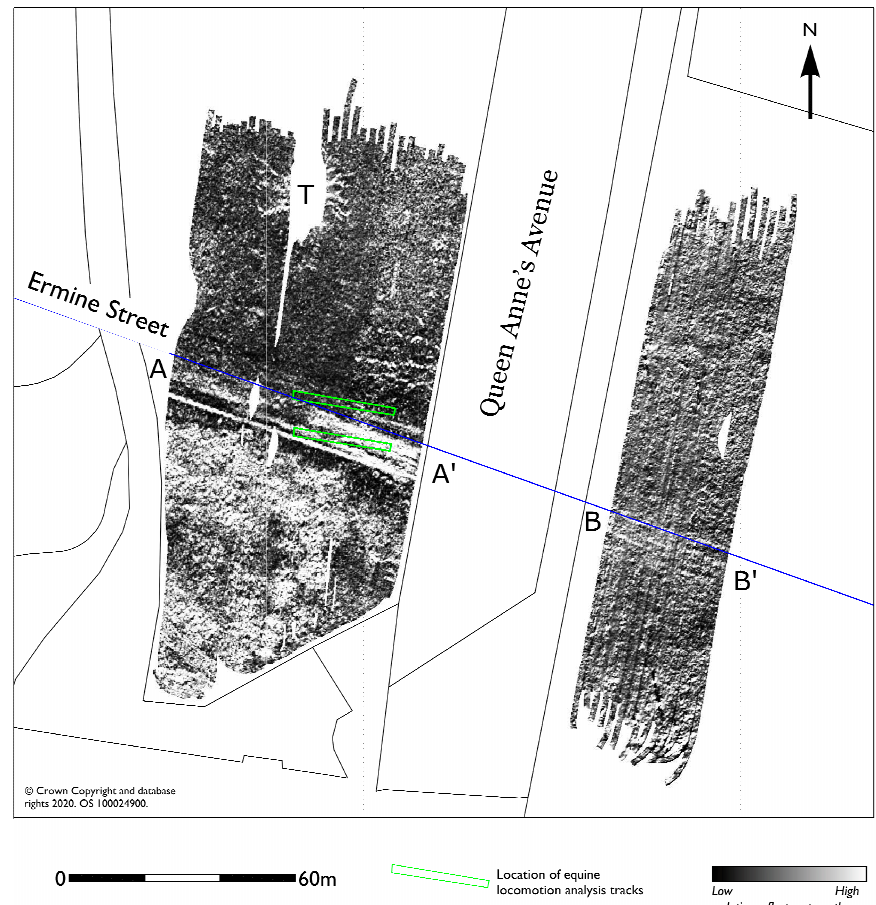
Figure 5. GPR amplitude timeslice from between 5.0 and 7.5 ns (0.27 to 0.4 m) showing the course of the Ermine Street Roman road (blue line) that survives better in the park land (AA’) to the west of Queen Anne’s Avenue, than in the field to the east (BB’) which has been subject to a more intense arable regime in recent years before being put down to grass. The two experimental tracks for the equine locomotion analysis are shown by the green boxes. Some gaps in the GPR coverage were necessary due to the presence of mature trees (T) where the root systems have also been imaged by the GPR survey.